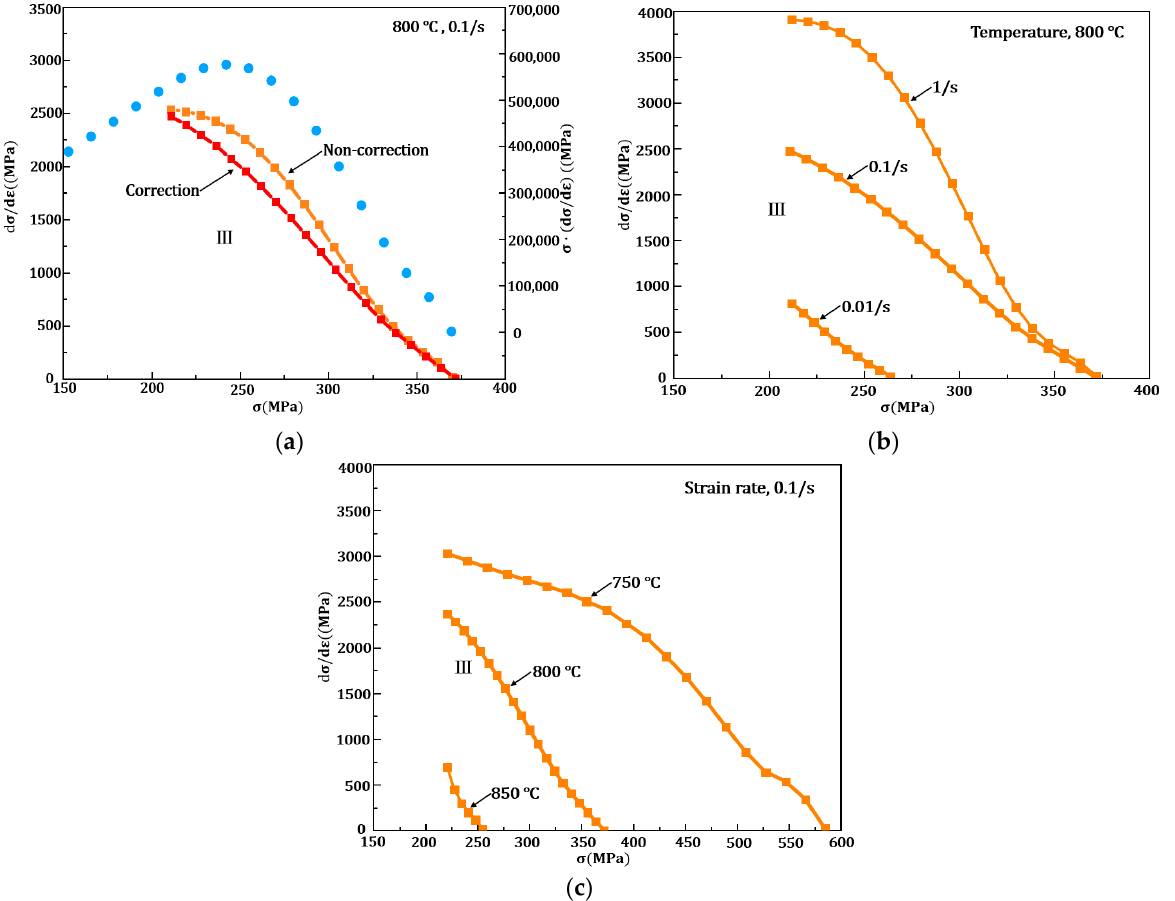
Figure 12. Hardening performance: ( a ) comparison of corrected and non-corrected hardening rate; ( b ) the corrected hardening rate at 800 °C (0.01/s, 0.1/s and 1/s); ( c ) the corrected hardening rate at 0.1/s (750 °C, 800 °C and 900 °C).